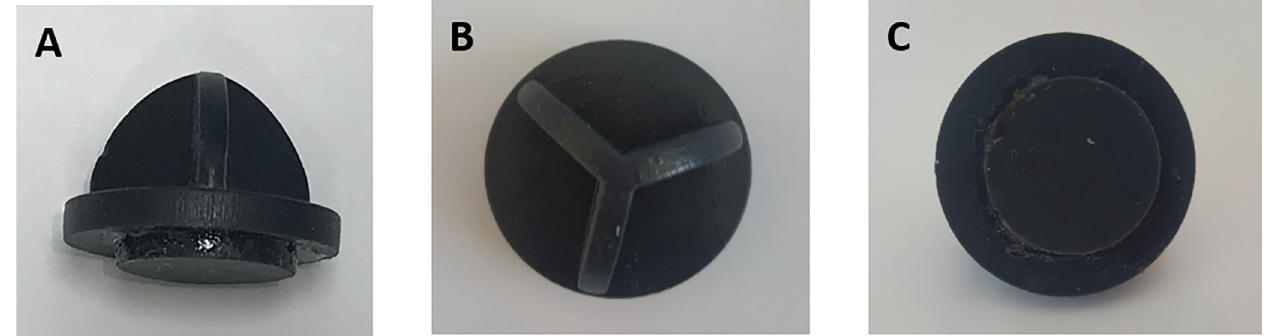
Fig 2. The new infant compression device (A: lateral view, B: viewed from above, C: viewed from below).